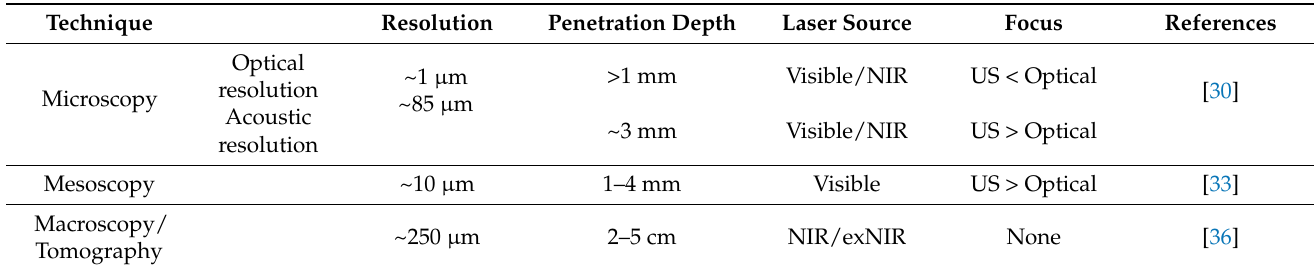
Table 1. Optoacoustic imaging (OAI) technologies across scales (US = ultrasound, NIR = near-infrared range, exNIR = extended near-infrared range).